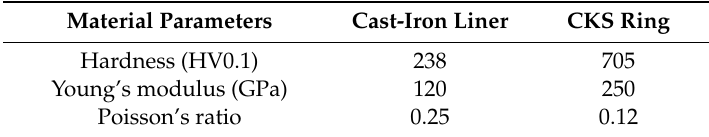
Table 2. Some material parameters of cast-iron liner and chromium-based ceramic composite coating (CKS) ring.